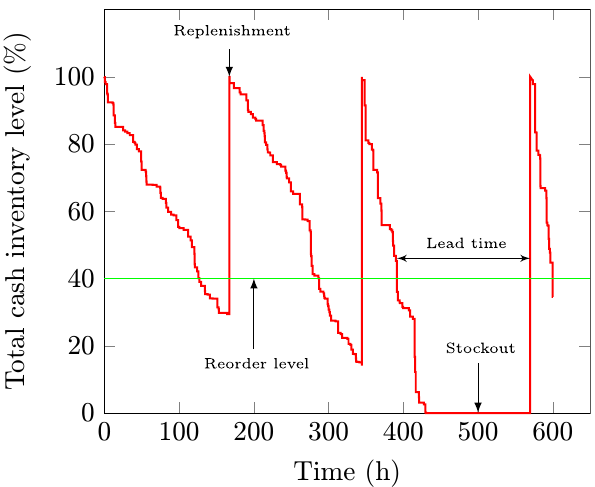
Figure 4: The schematic of the ( s, S ) inventory policy shows that the reorder point s can be var- ied, while the reorder quantity S is fixed because ATMs are filled completely during replenishment. The lines exhibit steps due to the discrete nature of the